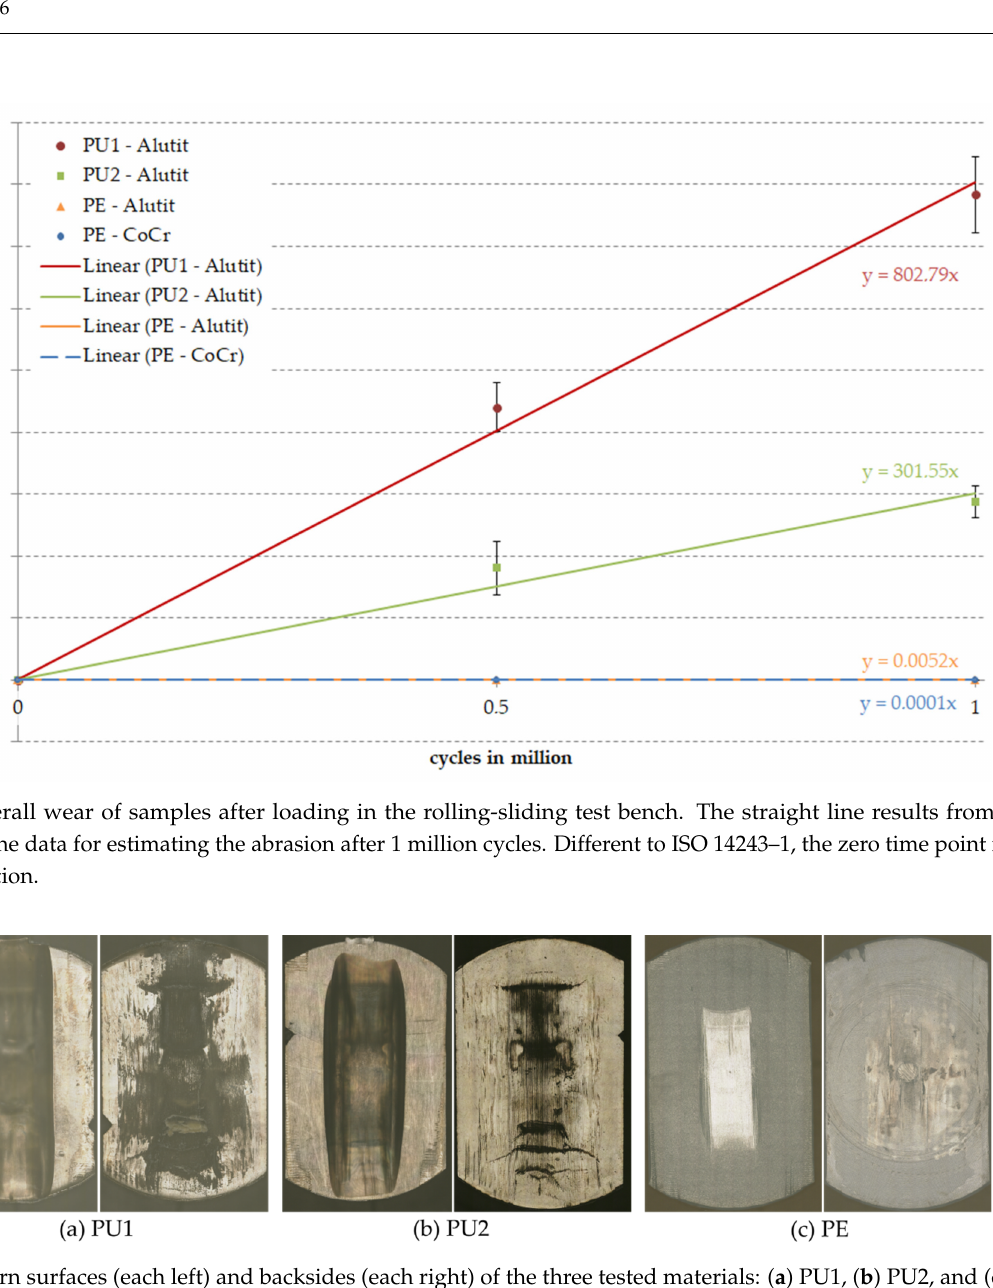
Figure 7. Worn surfaces (each left) and backsides (each right) of the three tested materials: ( a ) PU1, ( b ) PU2, and ( c ) PE.